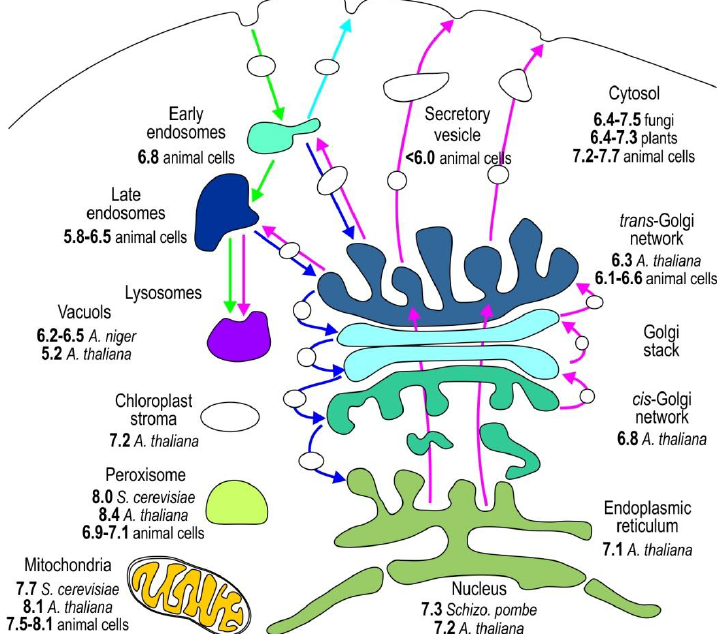
Figure 2. The pH of individual subcellular compartments in a prototypic eukaryotic cell. We show only pH values obtained using the genetically encoded pH-sensitive FPs as